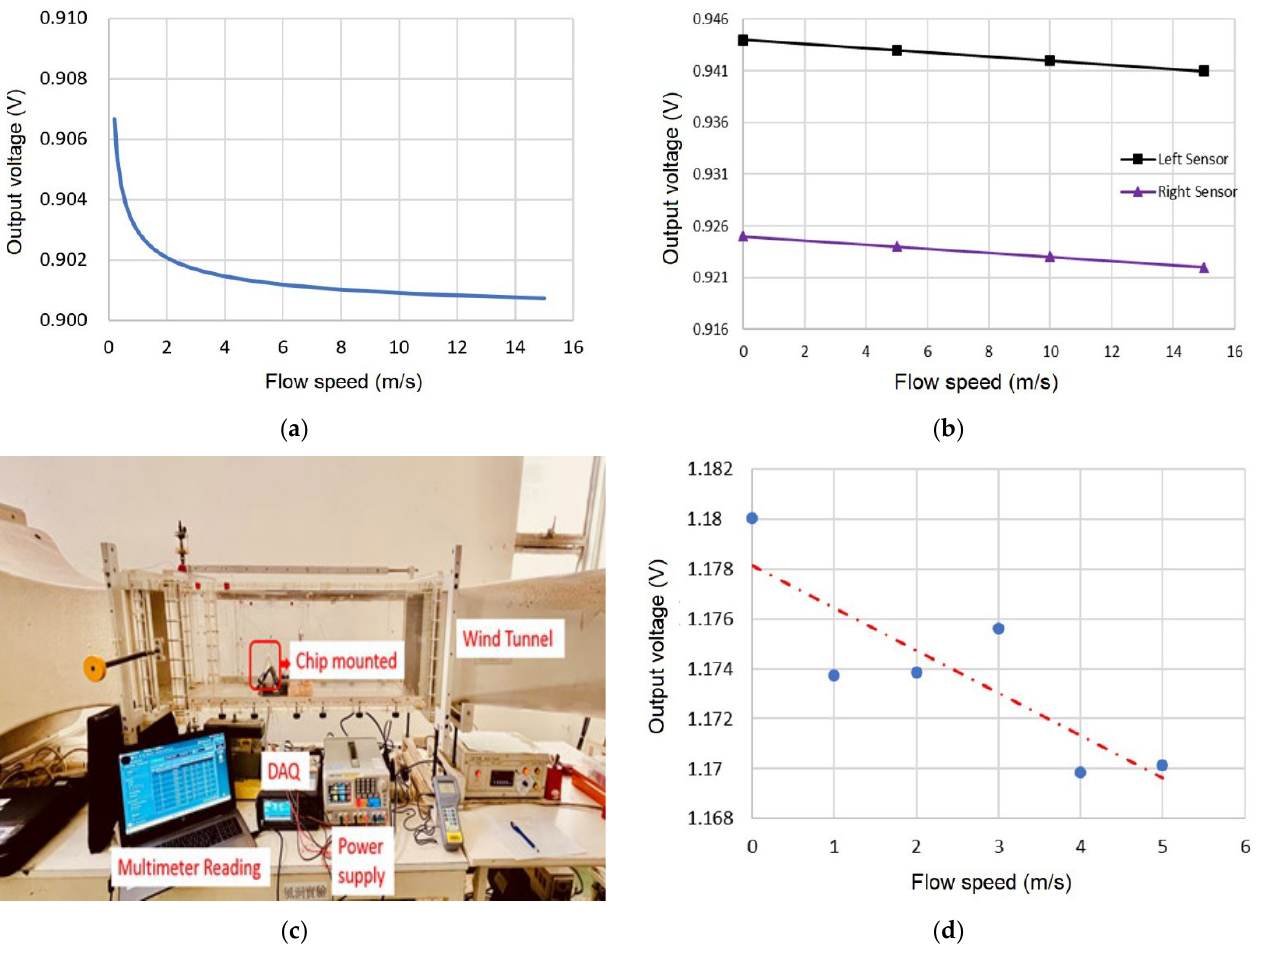
Figure 8. Flow sensor output voltage vs. flow speed: ( a ) theoretical prediction by Equations (1), (2), (4), and (5); ( b ) testing result of the fabricated CMOS MEMS self-heating flow sensor; ( c ) wind tunnel facility for flow sensor testing; and ( d ) testing result of the fabricated CMOS MEMS self-heating sensor with integrated amplifier circuit in Section 4.3.